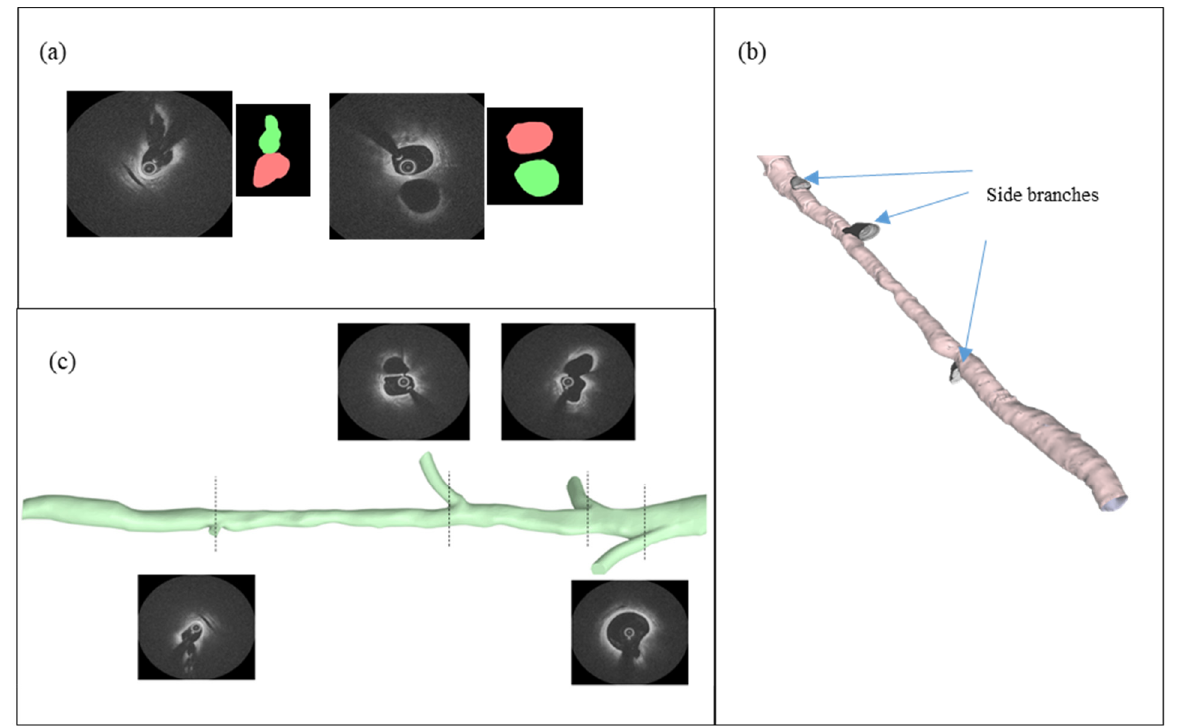
Figure 2. The 3D reconstruction of OCT-derived vessel tree geometry: ( a ) Segmentation of the main lumen and side branch lumen cross sections; ( b ) reconstructed geometry of the main vessel and side branches separately; ( c ) final vessel tree model generated by combining main vessel and side branches.